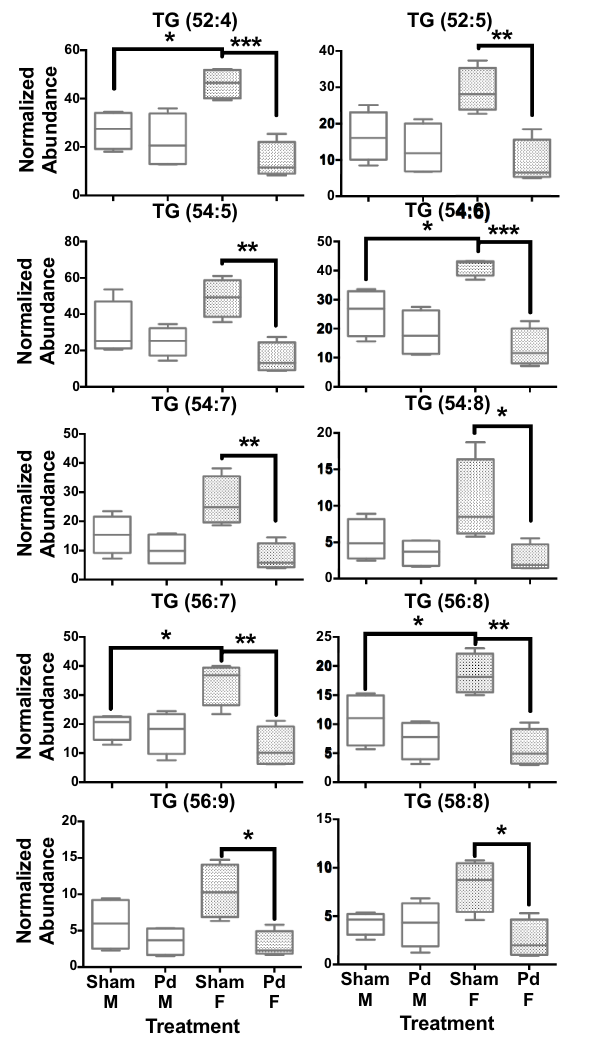
Figure 3. Box and whisker plots of hepatic TG concentrations in Eptesicus fuscus . TG concentrations tend to be highest in hibernating females compared to males. TG levels decrease significantly in females with Pseudogymnoascus destructans (Pd) infection compared to the sham treatment. There are no significant differences in hepatic TG concentrations between males and females in Pd-infected E. fuscus . * P ≤ 0.05; ** P ≤ 0.01; *** P ≤ 0.001 determined by a one-way ANOVA with multiple comparisons test, lines from top to bottom represent max value, 75th percentile, median, 25th percentile, min value, n = 4 for all